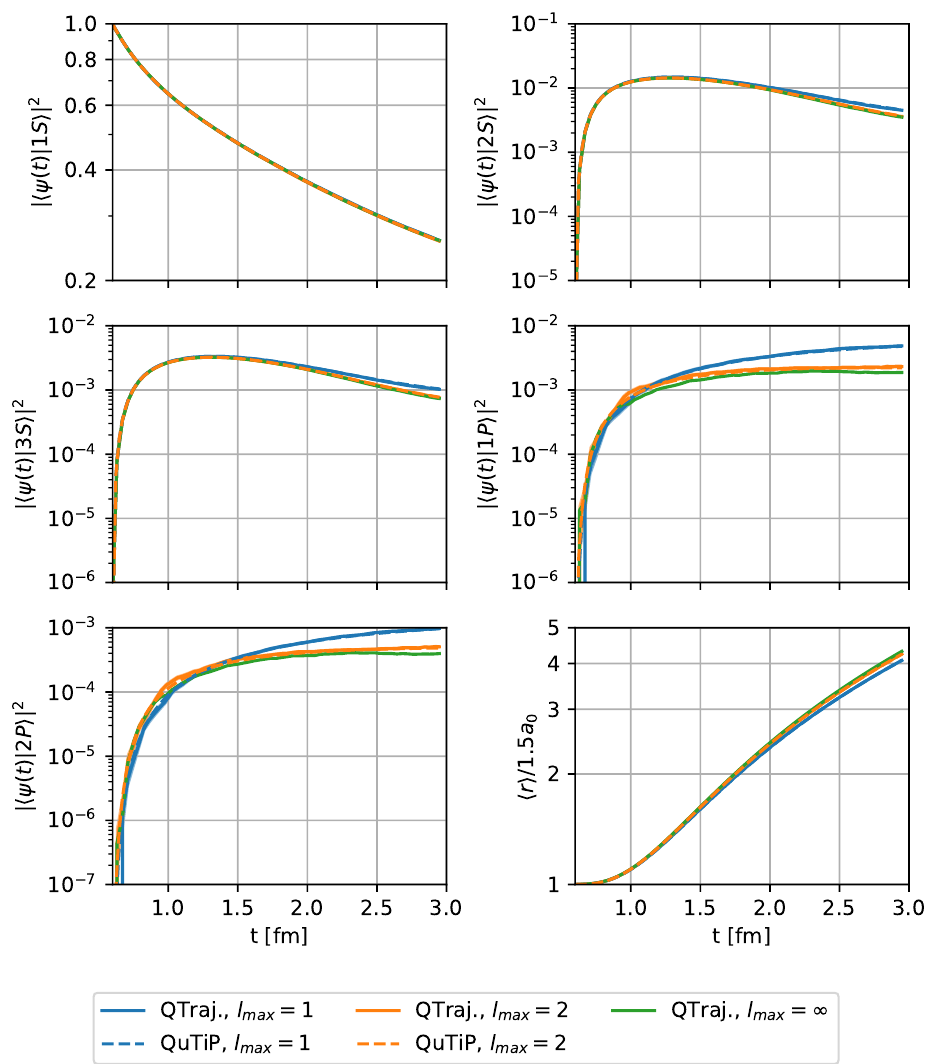
Figure 2 . A comparison of the overlap of an initial 1 S state with the lowest lying Coulomb states and the expectation value of the radius computed using QuTiP (dashed lines) and 196608 QTraj trajectories (continuous lines) for l max = 1 (blue lines), 2 (orange lines) and ∞ (green line, QTraj only). The parameters are taken κ/T 3 = 2 . 6 and γ = 0